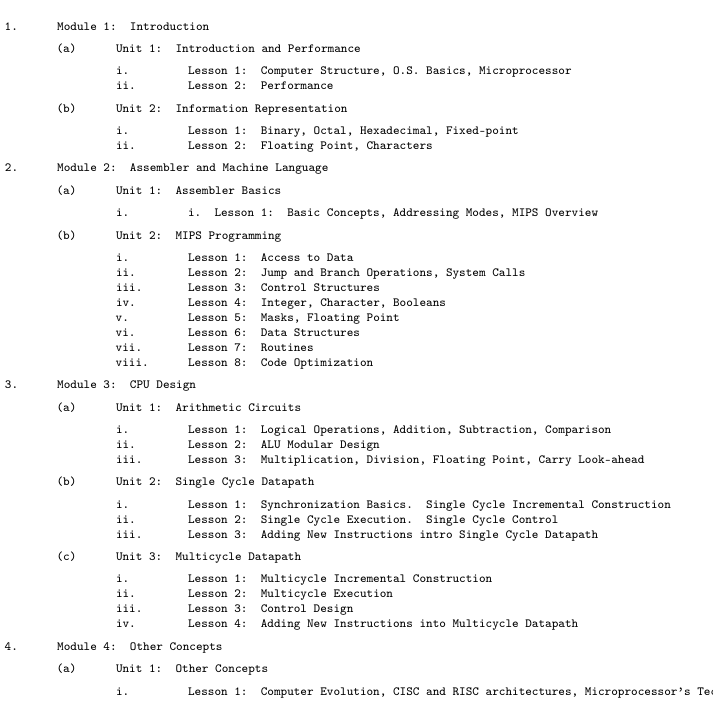
Figure 18. Structure of the course contents.